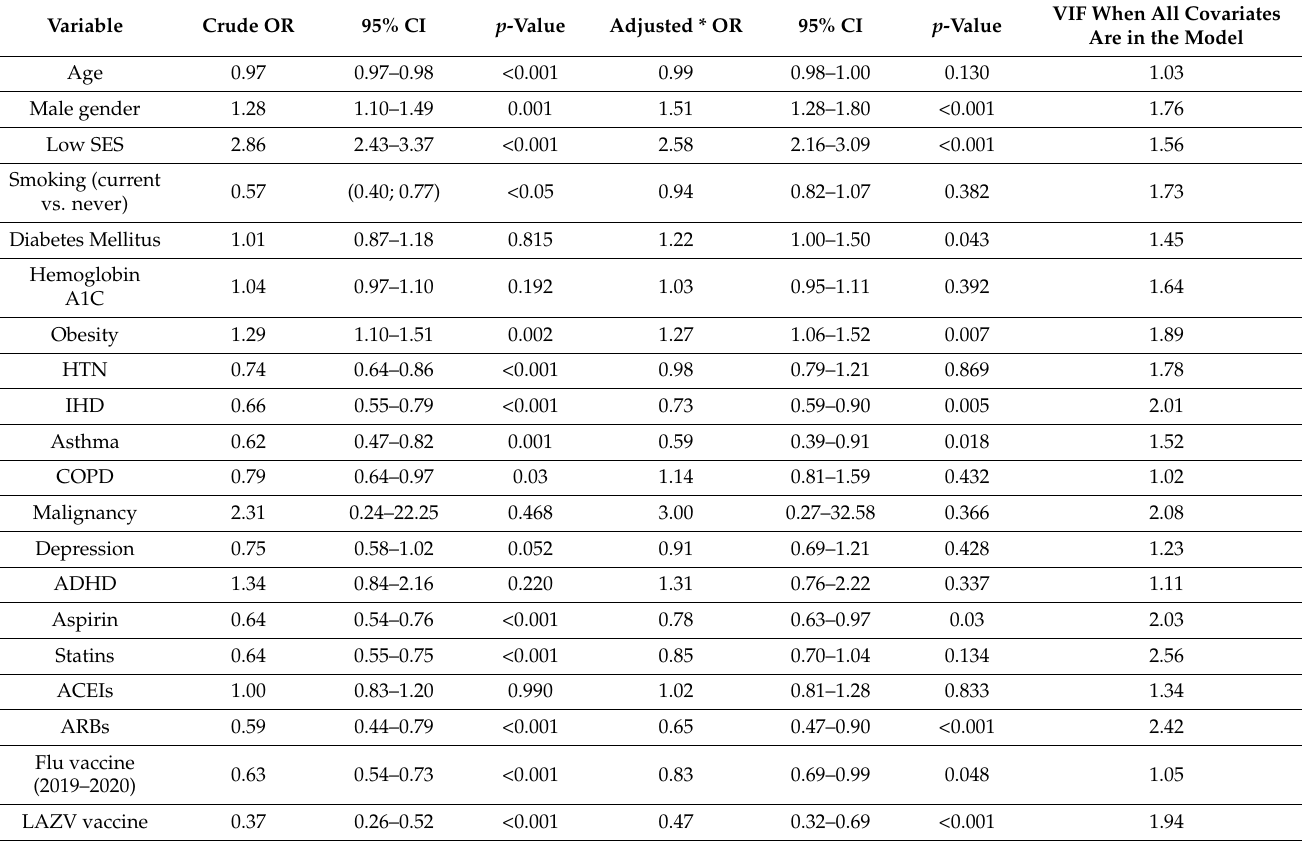
Table 3. Multivariate analysis of variables associated with COVID-19